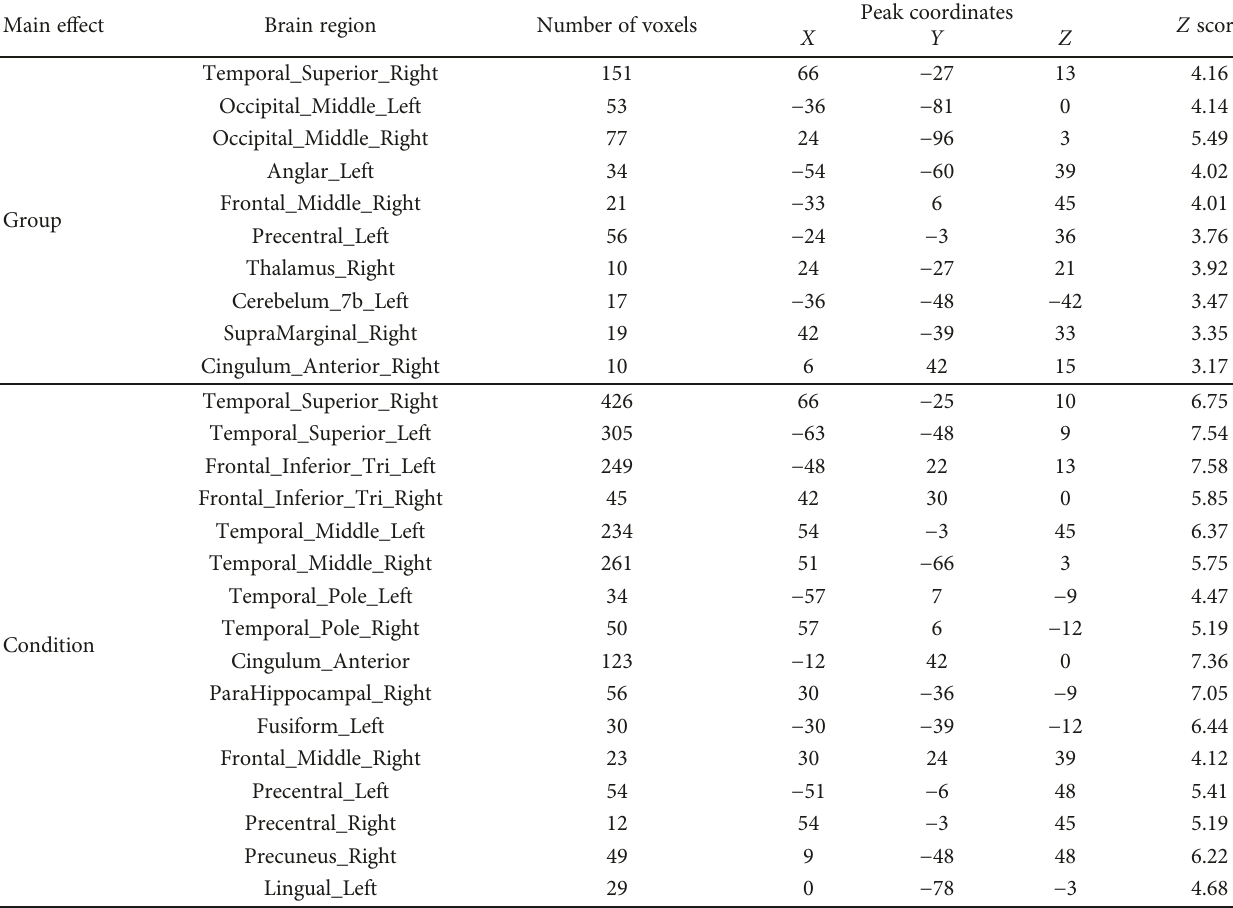
Table 3: Peak activations for the main e ff ect of Group and Condition (two-way ANOVA, p < 0 001 , FDR p < 0 05 corrected). Main e ff ect Brain region Number of